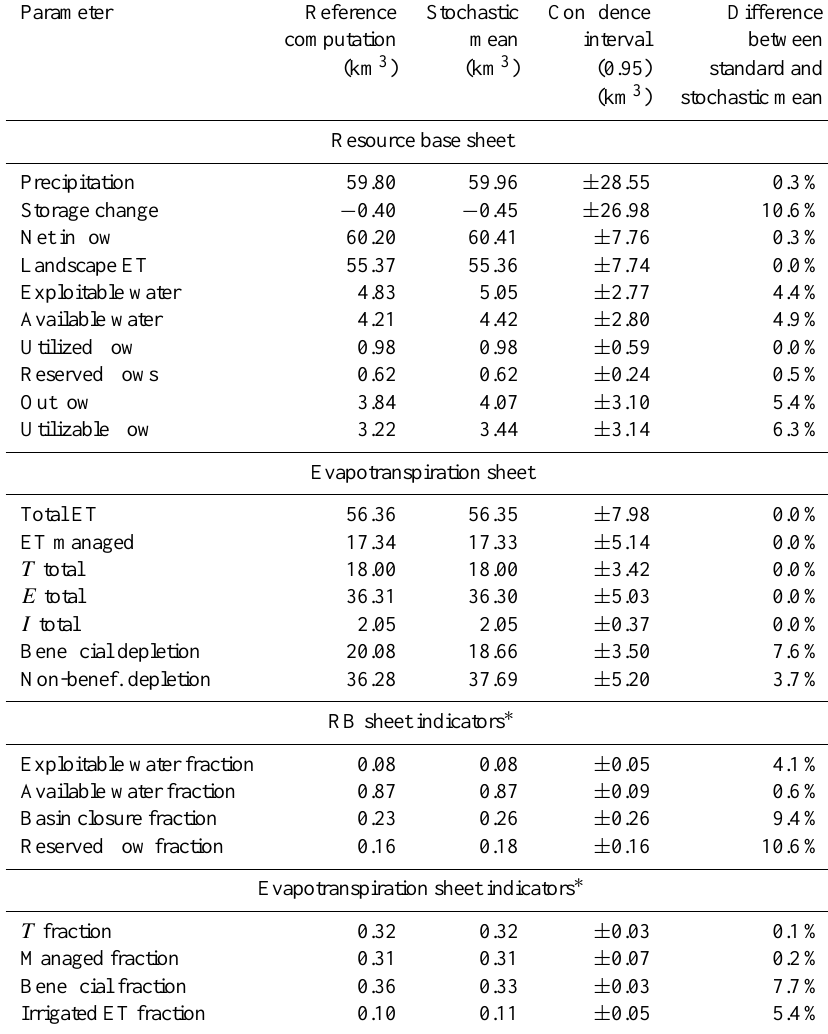
Table 8. Difference between standard and stochastic modeling of the WA + outputs for 2009 (RB – resource base).